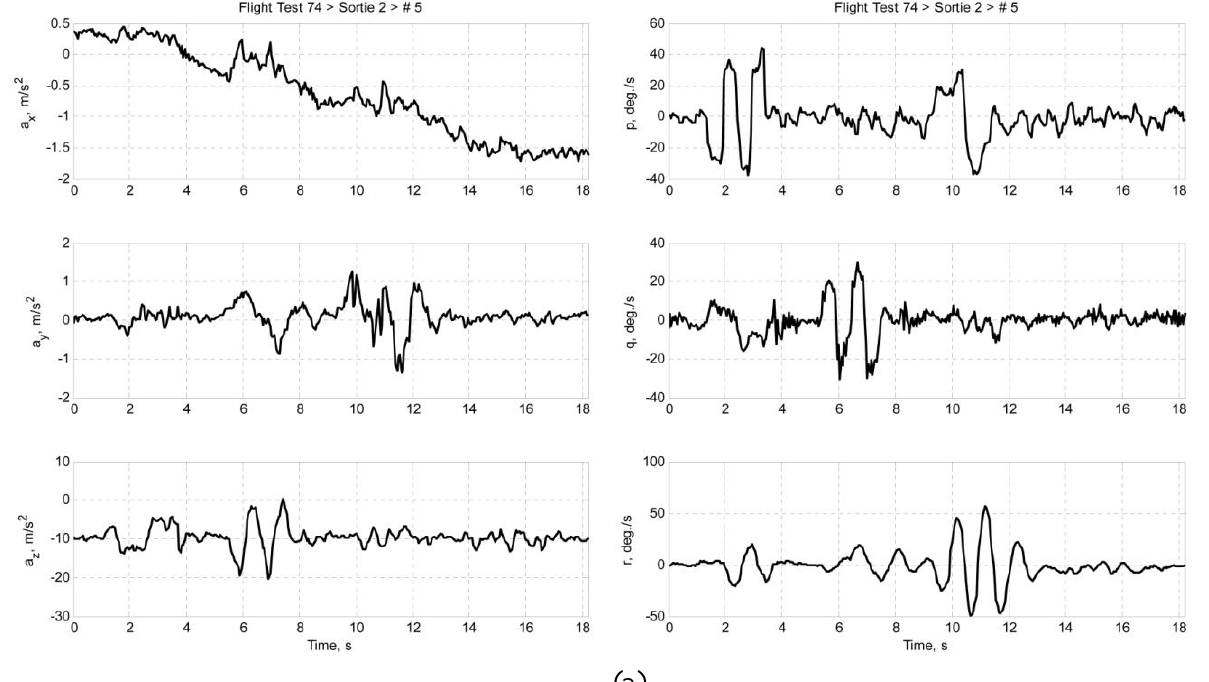
Figure 7. (a) Accelerations and angular rates of ft74srt02run05. (b) Airdata and attitude angles of